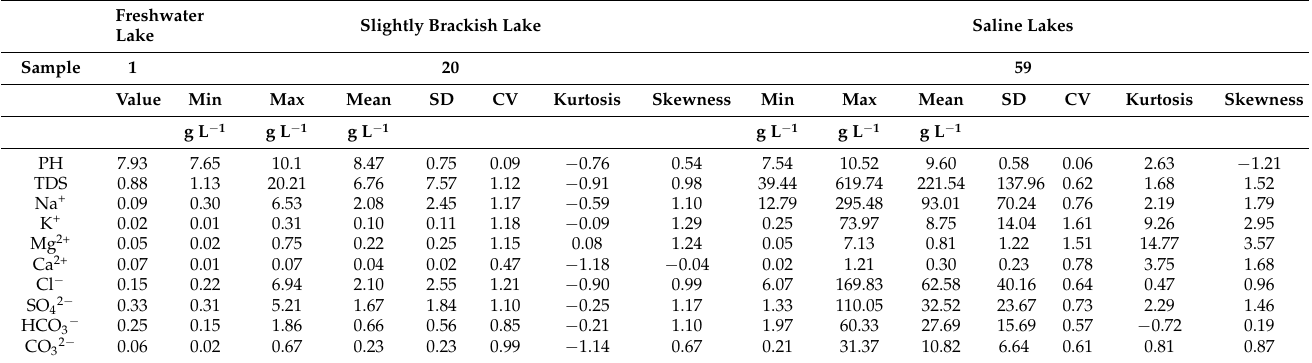
Table 1. Descriptive statistics of lakes physico-chemical properties in the Badain Jaran Desert. Freshwater Lake Slightly Brackish Lake